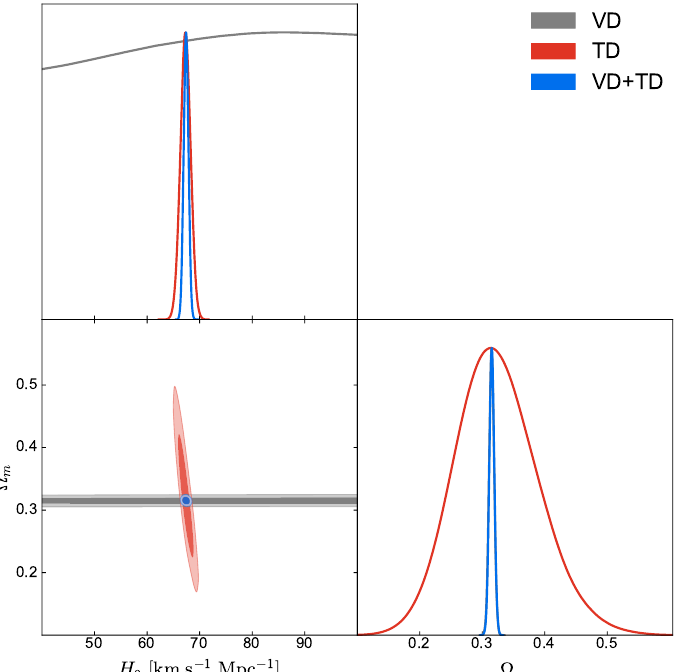
Figure 4. The constraints (68.3% and 95.4% confidence level) on the Λ CDM model from the simula- tions of VD, TD, and VD+TD.